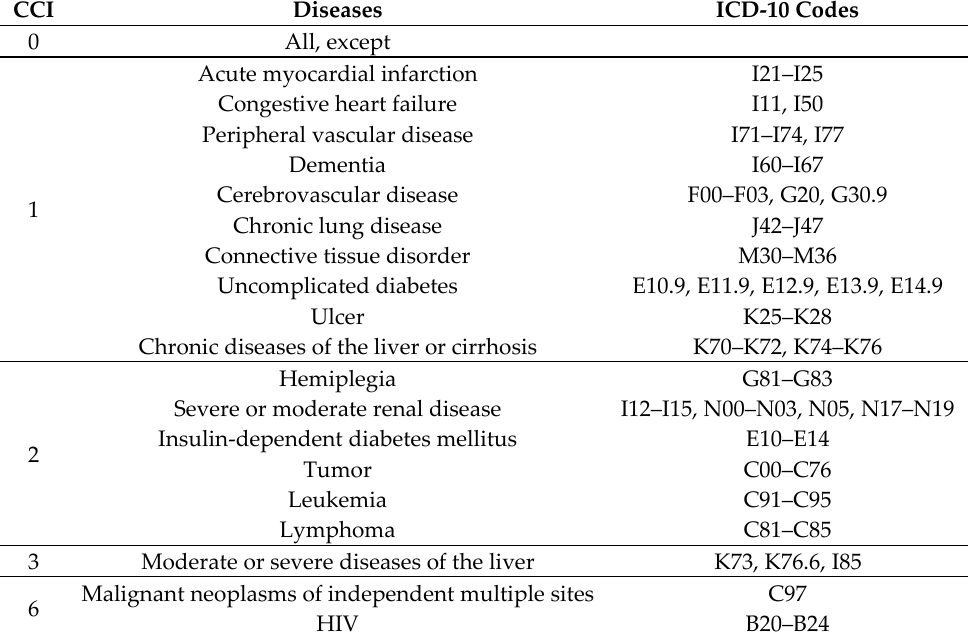
Figure 1. The Charlson Comorbidity Index distribution.